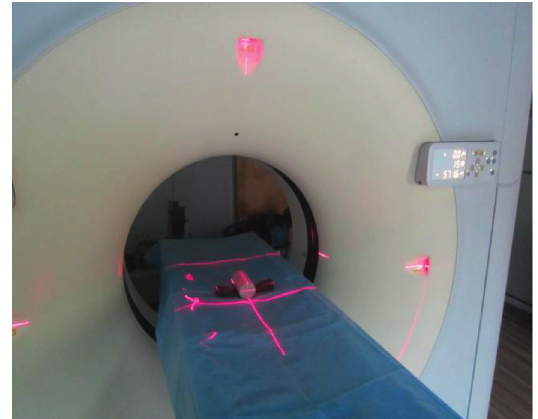
Figure 4: CT scanning test.